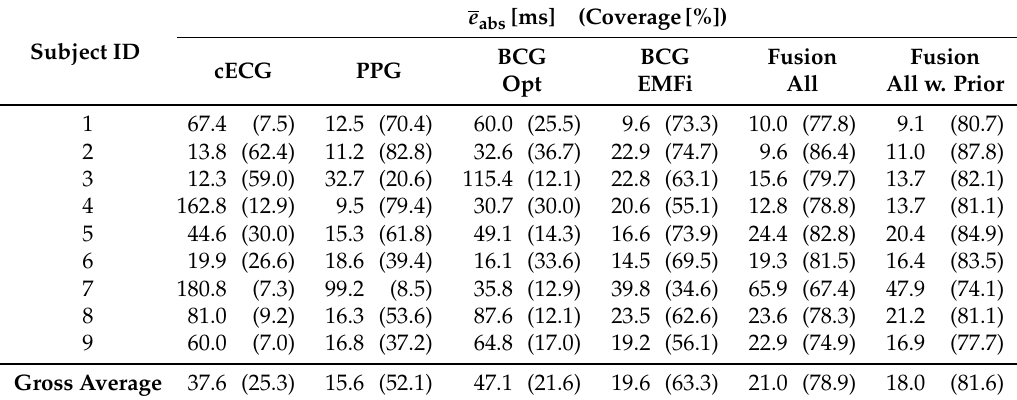
Table 4. Mean absolute interval estimation error ( e abs ) in milliseconds and coverage in percent for all subjects in the motion artifact scenario.